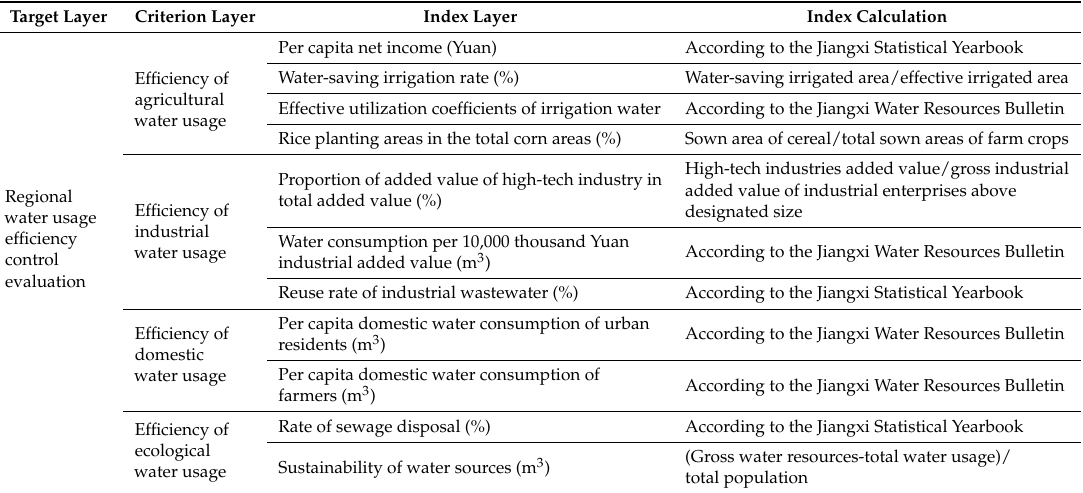
Table 5. Evaluation index system of regional water use efficiency